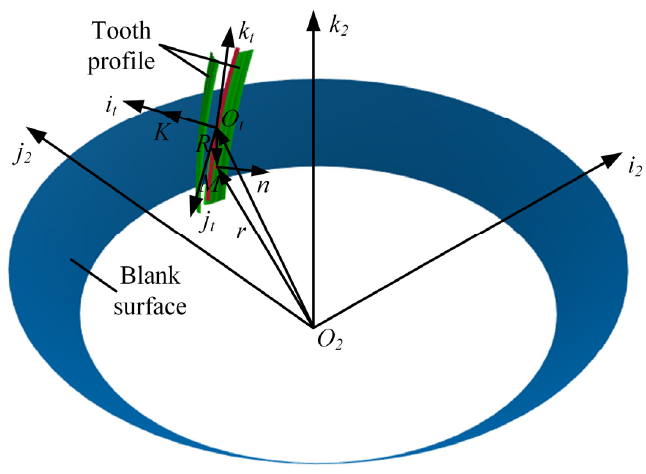
Figure 8. Coordinate system for tool section solution.